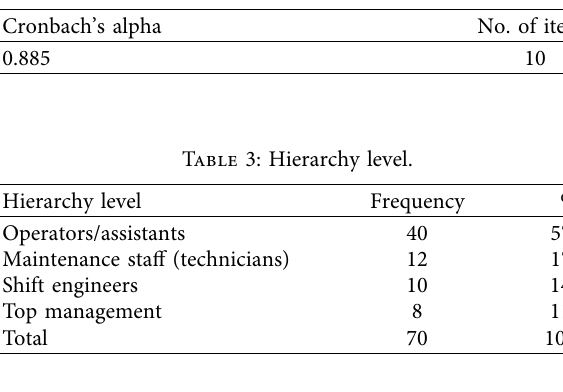
Table 2: Reliability statistics.